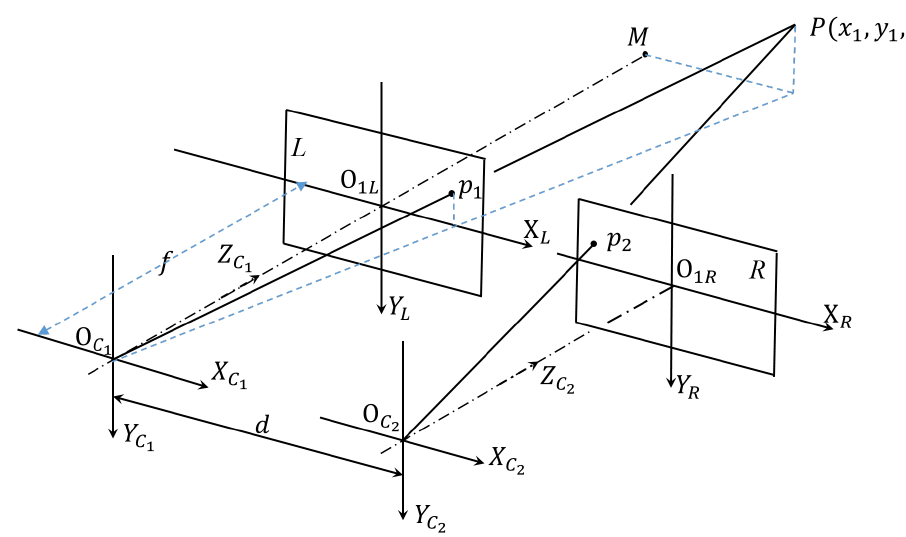
Figure 7. Schematic for 3D reconstruction for a point P in the binocular vision